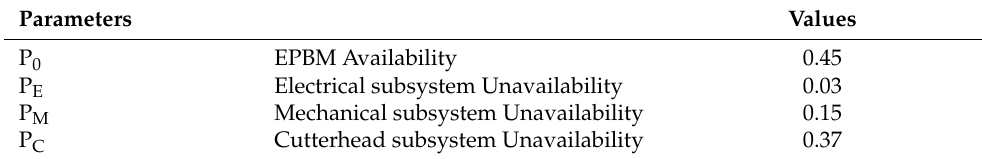
Table 4. Availability of EPBM in Line 1 using the Markov method.